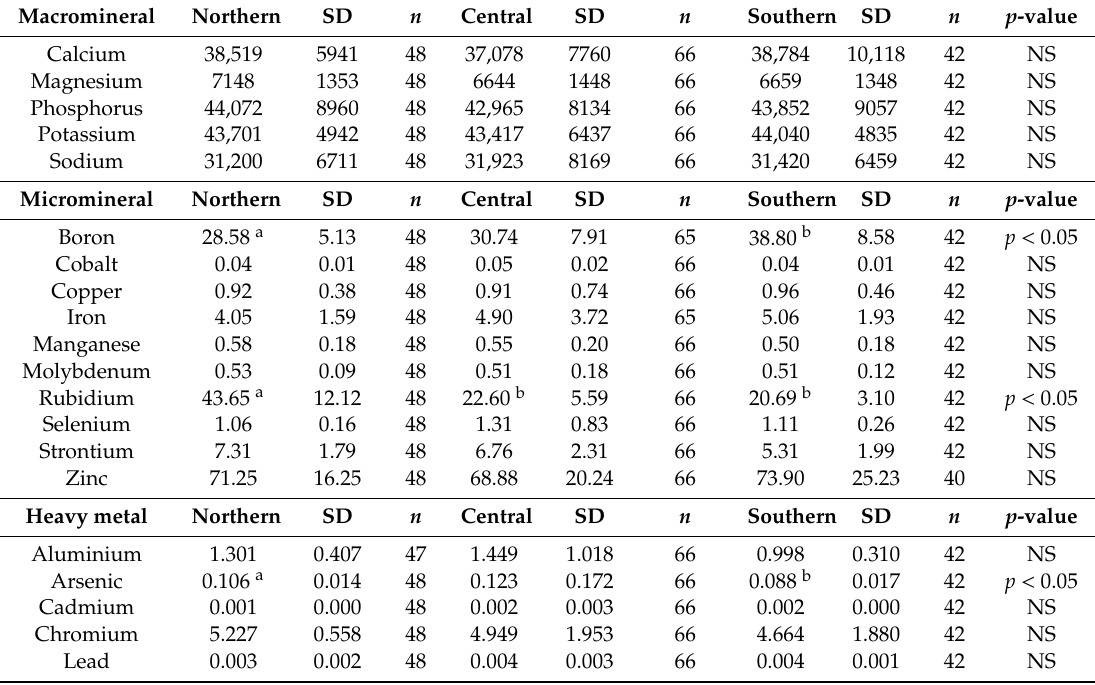
Table 1. Concentration of macro- and microminerals as well as heavy metals in the raw milk of dairy cows in subregions of Alberta,